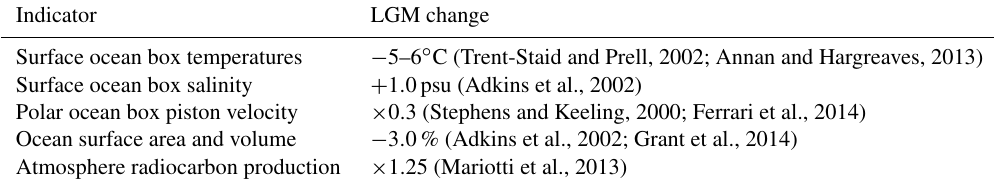
Table 3. Changes to ocean and atmosphere parameter settings in SCP-M to recreate the LGM background model state.